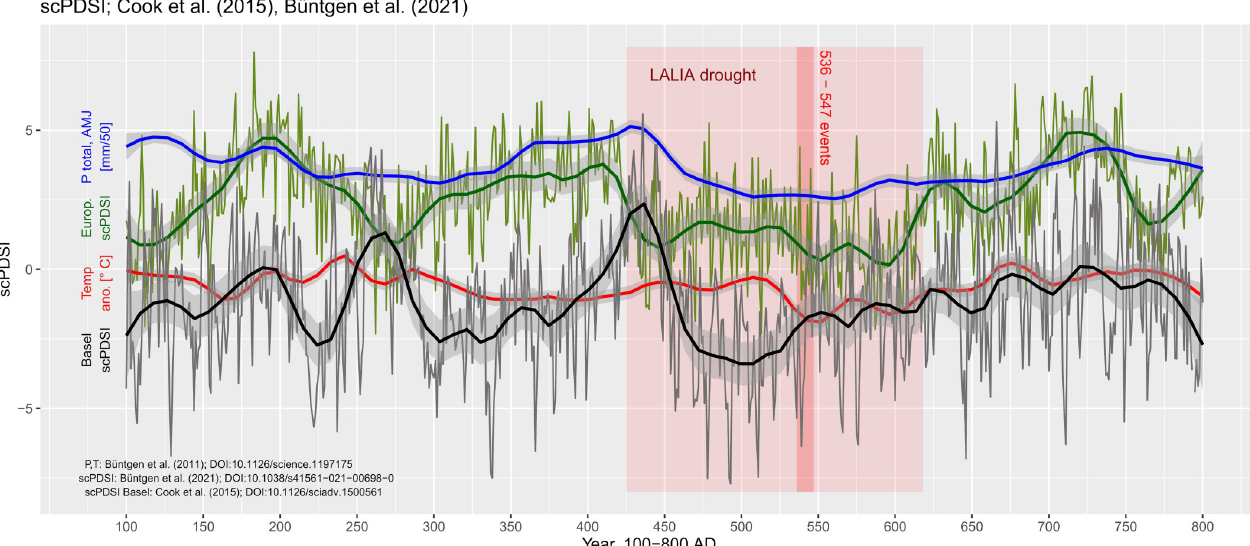
Fig 4. Climate anomalies during 100–800 AD. Green curve shows the Central European scPDSI reconstruction based on [17] and the black curve is the scPDSI at Basel [16], both lines are smoothed with a loess smoothing parameter of 0.1. Blue and red lines are equally smoothed precipitation totals (mm/50) and temperature anomalies (˚ C) based on [18]. The Late Antique Little Ice Age (LALIA) is highlighted in red; the 536–547 AD volcanic events are marked by a red bar.